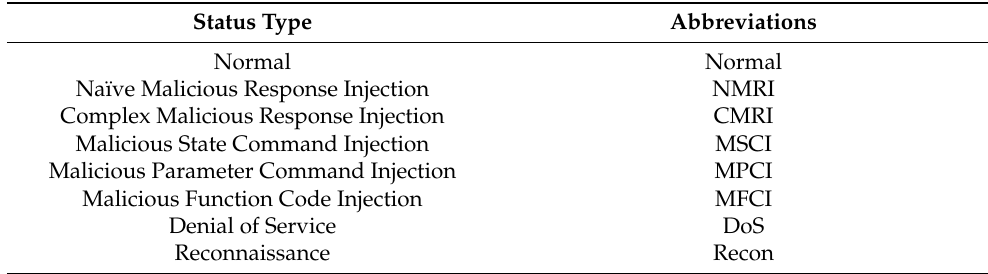
Table 3. Data types included in the